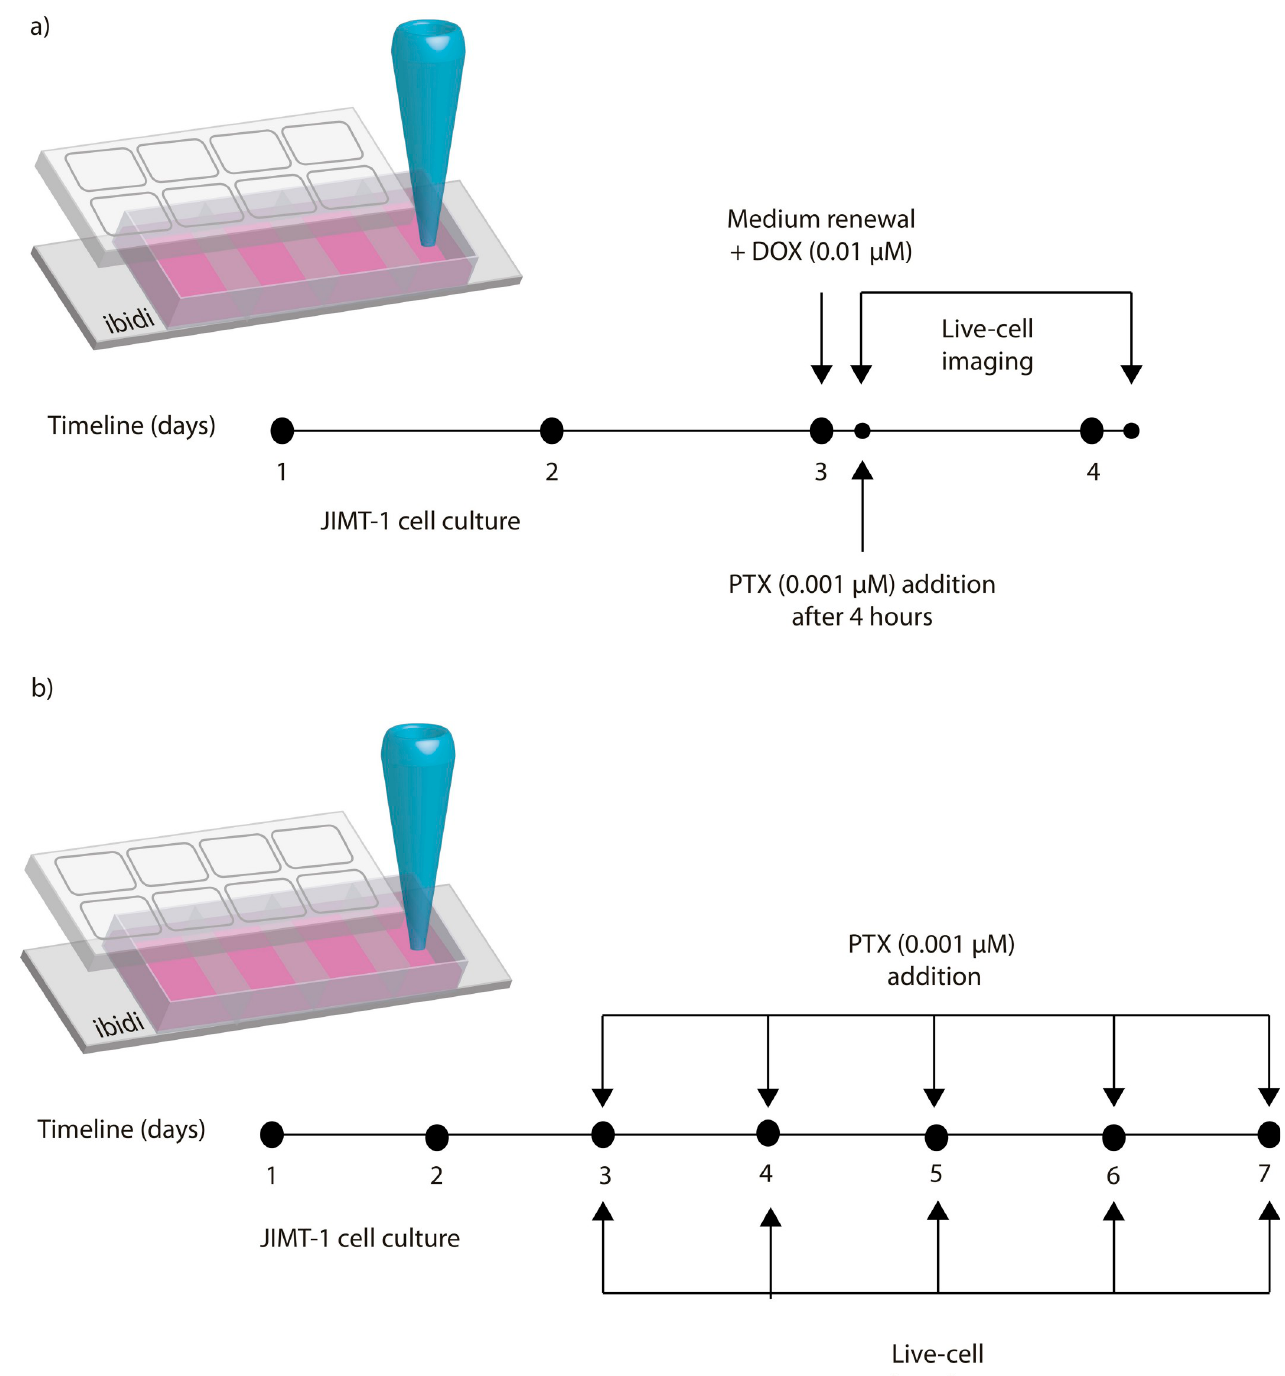
Fig 2. Timeline of applied pharmacological strategies. a) Combined DOX and PTX treatment DOX (0.01 μ M) and 4 hours later PTX (0.001 μ M). b) Metronomic PTX treatment (0.001 μ M) for 5 days.